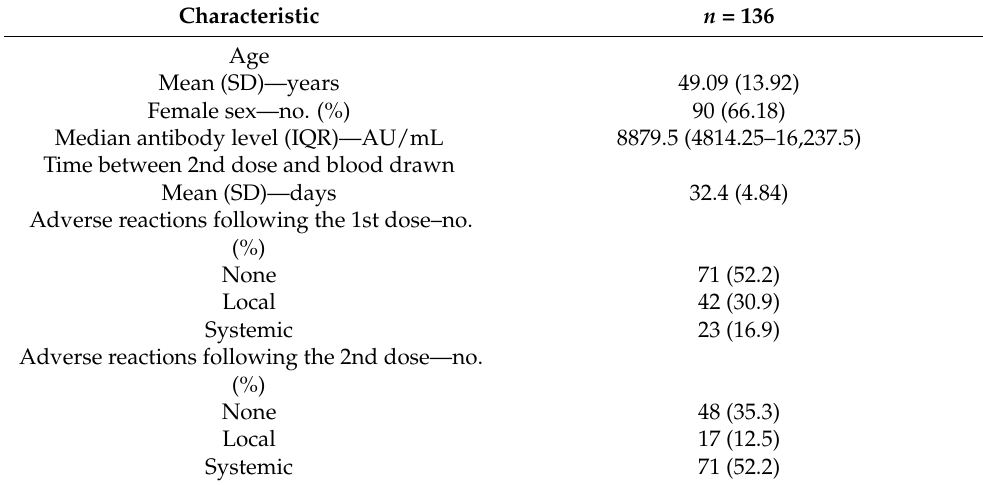
Table 1. Study population characteristics.